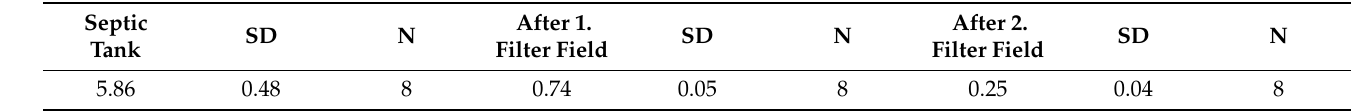
Table 6. Average concentration of surfactants (mg/L) with standard deviation (SD) in waste water samples from the root WWTP built in a closed recirculation circuit.